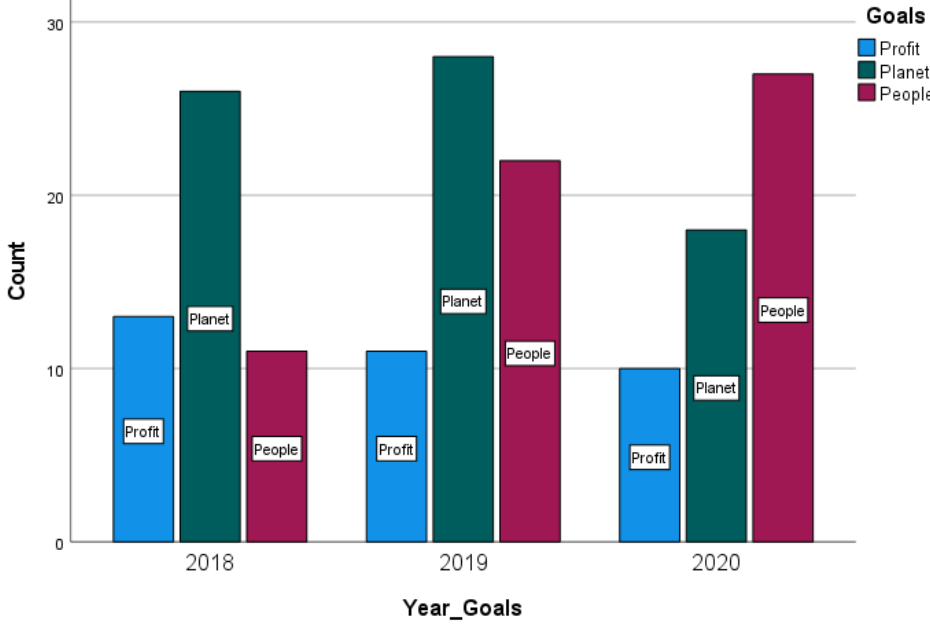
Figure 2: CSR Goals by Year